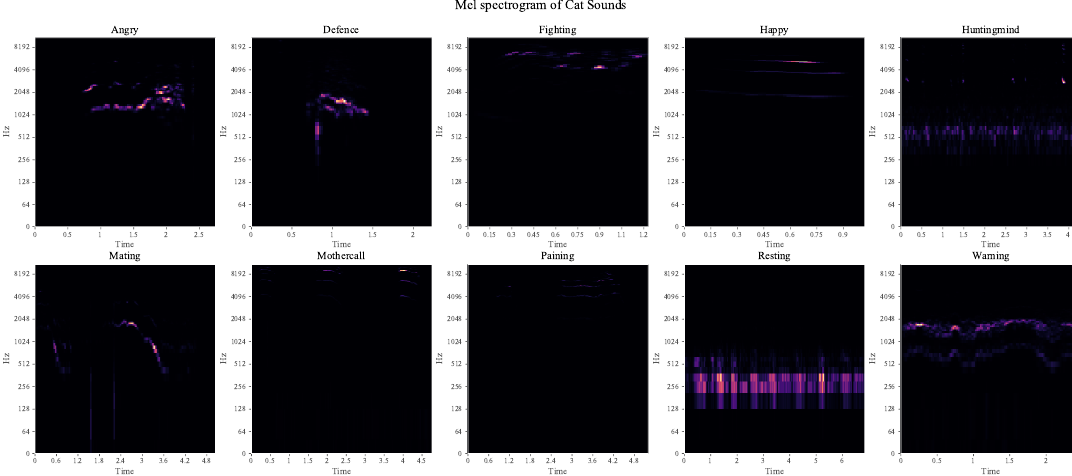
Figure 5. The sample in Figure 2 transformed to mel